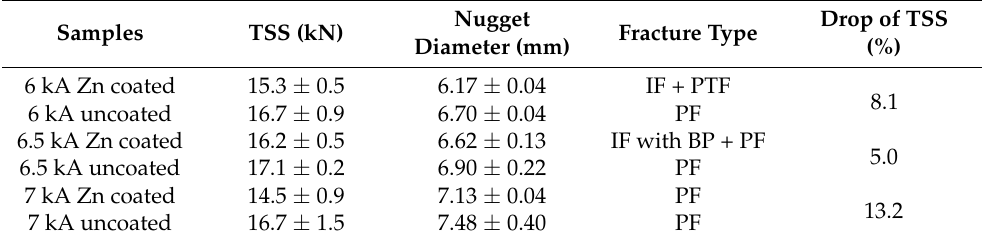
Table 6. Results from the comparison of coated and uncoated samples examined by tensile shear tests (tensile shear strength—TSS, partial thickness fracture—PTF, button pull-out—BP, button pull-out fracture—PF, interfacial